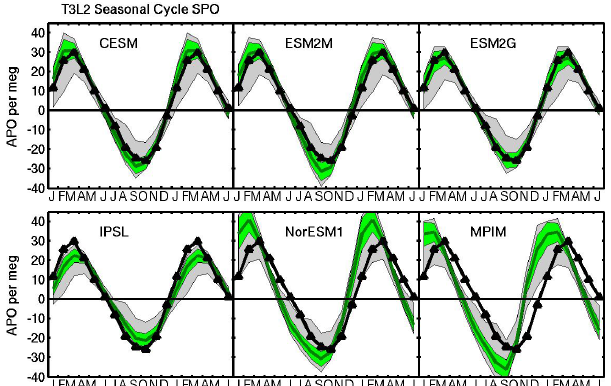
Figure 2a. Results of the pulse-response code forced by O 2 , N 2 and CO 2 air–sea fluxes from six ESM ocean biogeochemistry model components. The dark green line and light green window show the mean and standard deviation, respectively, of the nine ATMs par- ticipating in both T3L2 and APO TransCom. The amplitudes are scaled for each ATM and monitoring site based on the validation exercise described in Sect. 2.2.2 and illustrated in the Supplemen- tary material. The gray window shows the full range of responses from all 13 T3L2 ATMs, uncorrected based on the APO TransCom validation exercise. The heavy black line shows the observed APO mean annual cycle. (a) Results at South Pole, compared to SIO ob-